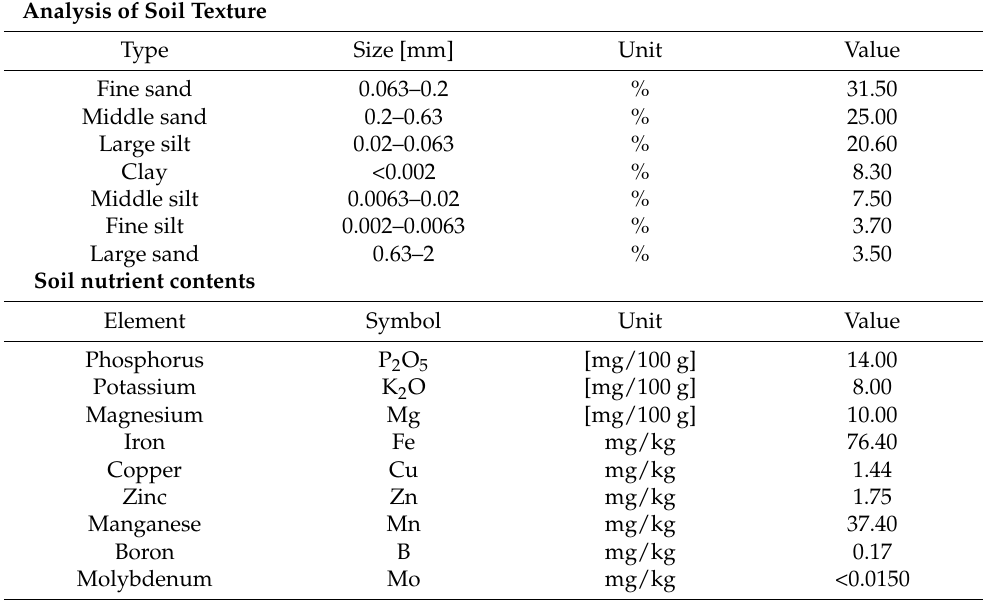
Table 1. Texture and nutrients contents of the soil used to fill the pots. Analysis of Soil